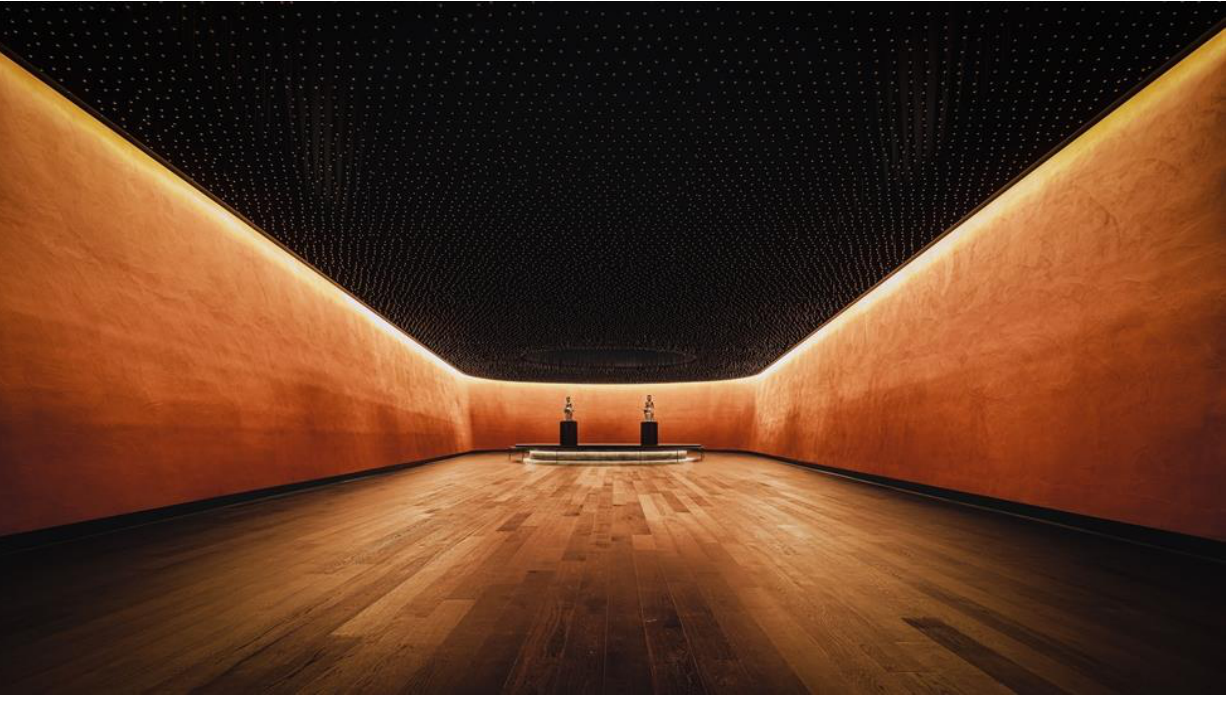
Figure 9. View from the entrance unto “A Room of Quiet Contemplation”. Photos from The Korean JoongAng Daily, 1 February 2022. Photos in public domain.